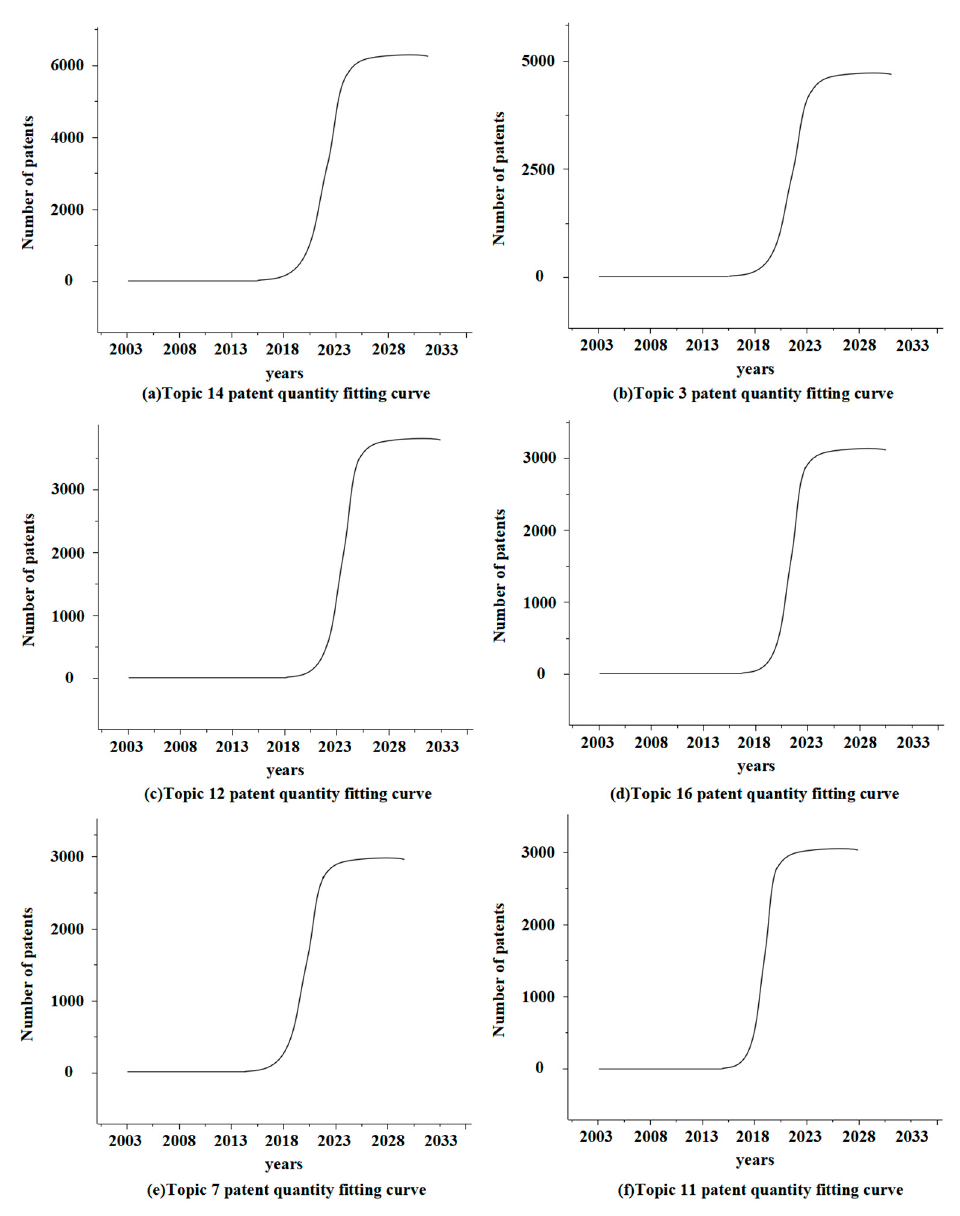
Figure 7. Fitted curve of six key CCUS technologies based on the number of patents. Table 5. Development stages of key CCUS technologies.